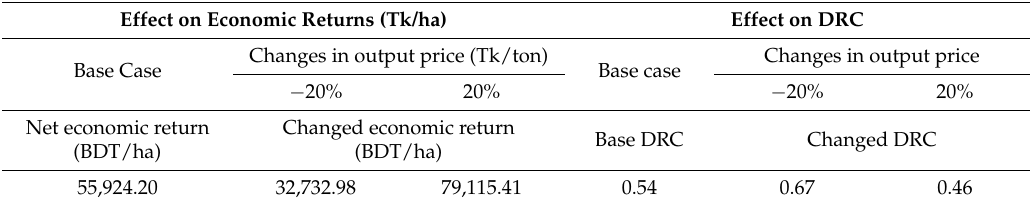
Table 3. Effect of changes in output prices on economic returns and DRC.